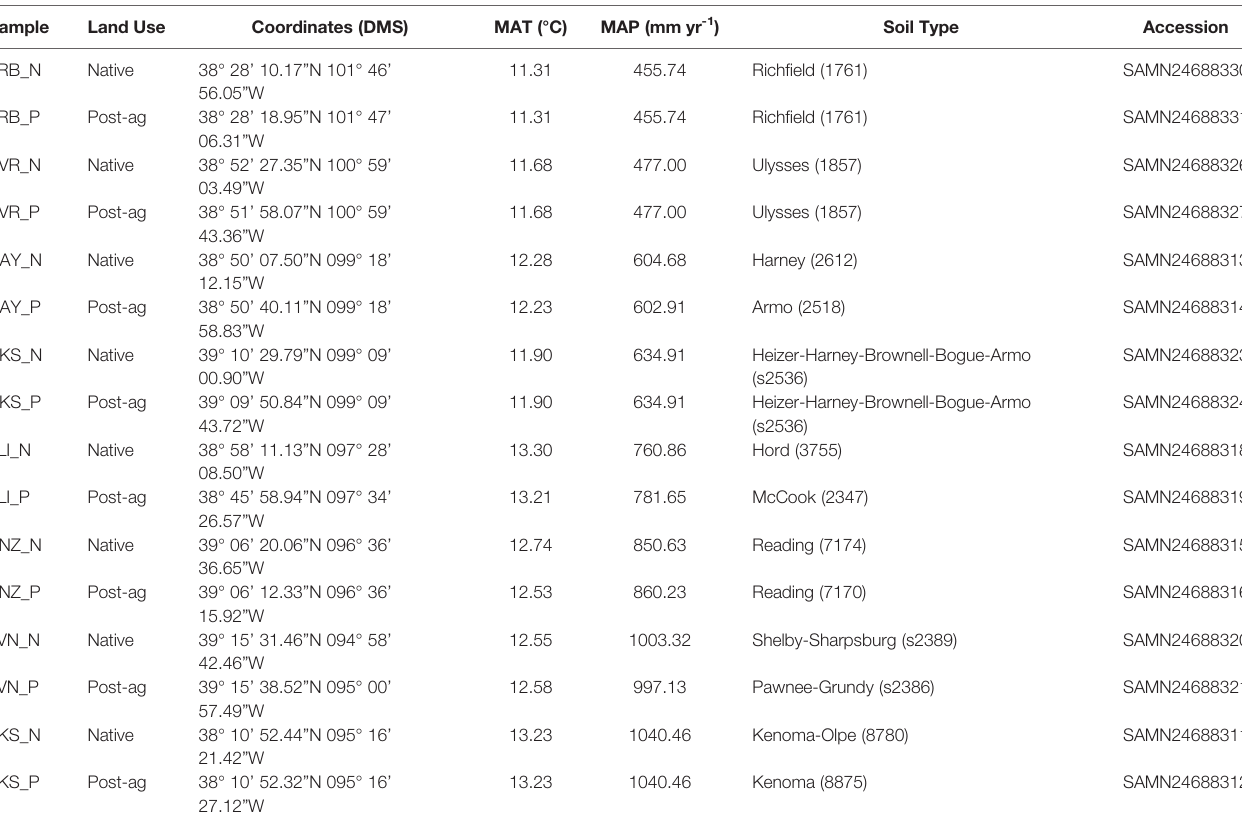
TABLE 1 | Site details including site identi fi ers, land use history (native prairie remnant or post-agricultural site), coordinates, mean annual temperature (MAT), mean annual precipitation (MAP) (acquired from PRISM Climate Group at Oregon State University; https://prism.oregonstate.edu/), soil type (as de fi ned in USDA Natural Resources Conservation Service SSURGO database) and Sequence Read Archive accession under BioProject